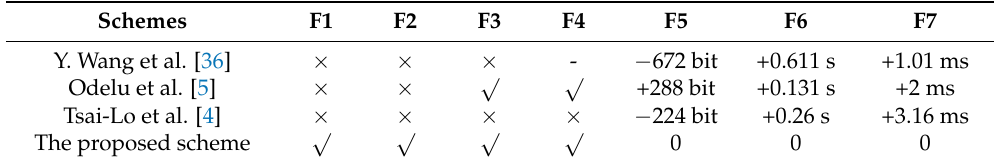
Table 18. System comparison.